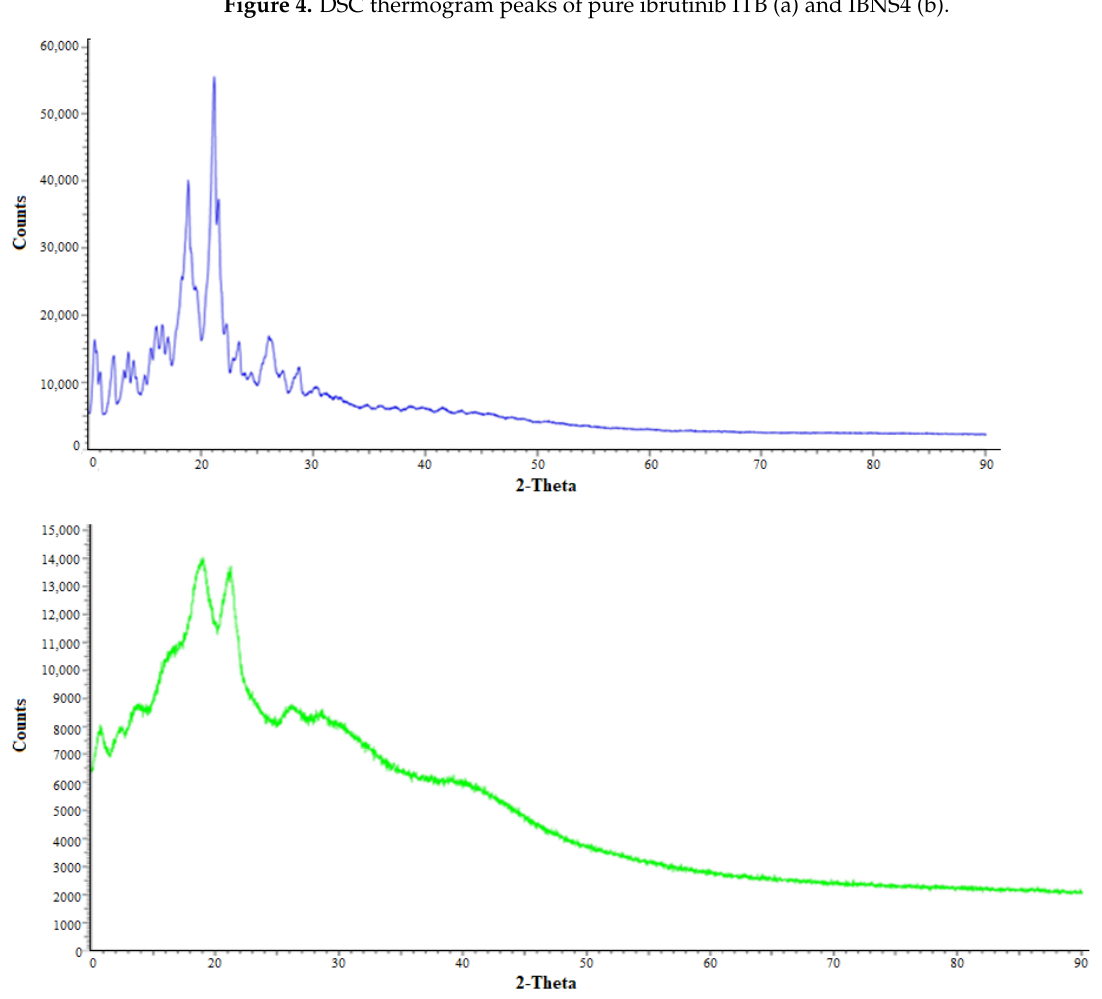
Figure 5. XRD Bragg peaks of pure ibrutinib ITB (blue) and IBNS4 (green).